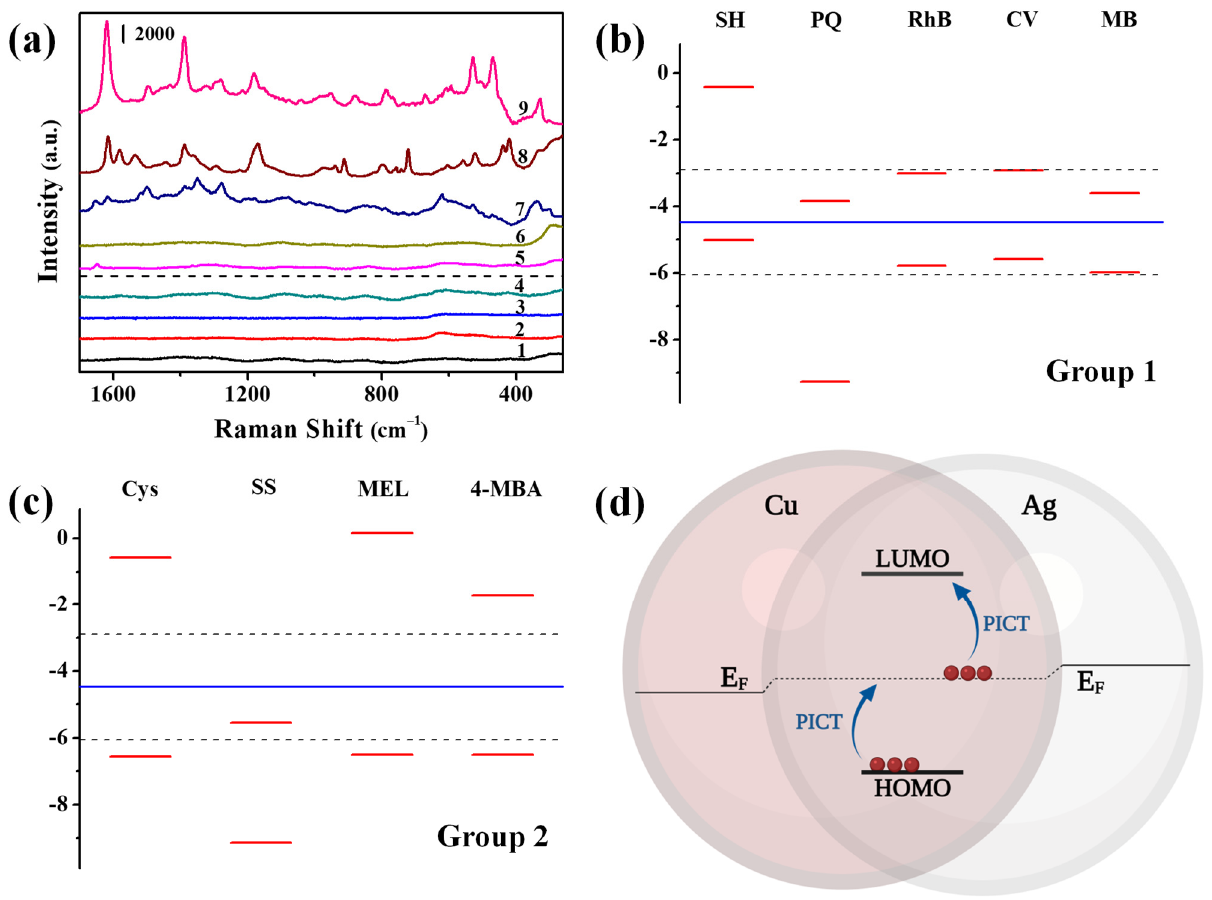
Figure 7. ( a ) SERE spectra of (1) Cys, (2) SS, (3) MEL, (4) 4-MBA, (5) SH, (6) PQ, (7) RhB (8) CV and (9) MB at 1 ppm on the Cu-Ag SERS chip. The energy level diagram of the molecules in ( b ) Group 1 and ( c ) Group 2. ( d ) The electron transition model between Cu-Ag chip and target molecules.